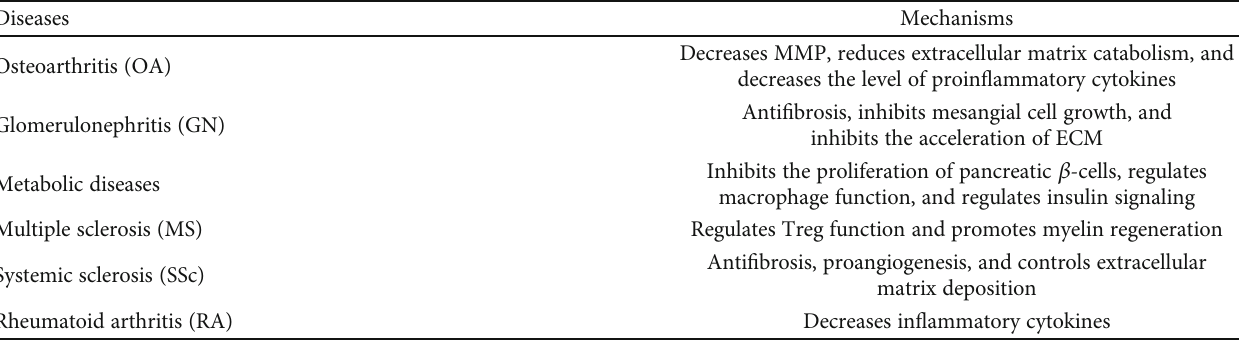
Table 1: Immune-related diseases in fl uenced by